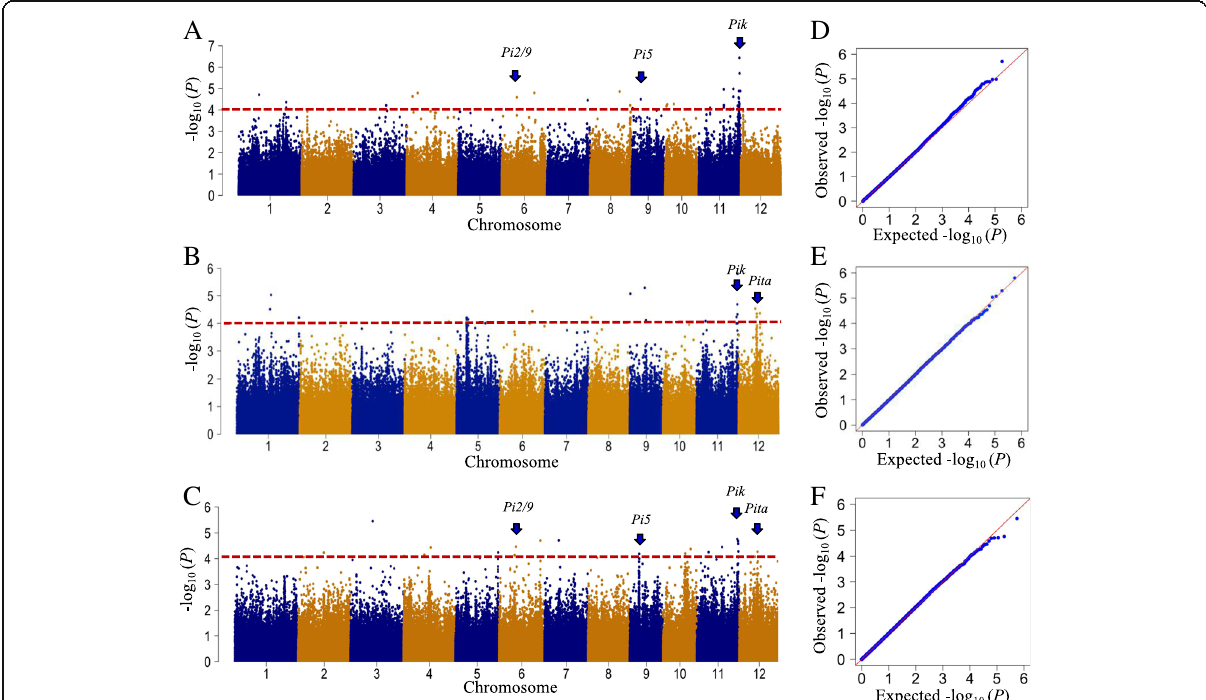
Fig. 2 Genome-wide association studies of rice resistance to three M. oryzae isolates. a . Manhattan plot of GWAS results for rice resistance to 110-2. b . Manhattan plot of GWAS results for rice resistance to 193-1-1. c . Manhattan plot of GWAS results for rice resistance to 87-4. The X-axis indicates the SNPs physically mapped on 12 chromosomes. d, e and f . Quantilequantile plots of expected and observed -log10(p-value) to three isolates,